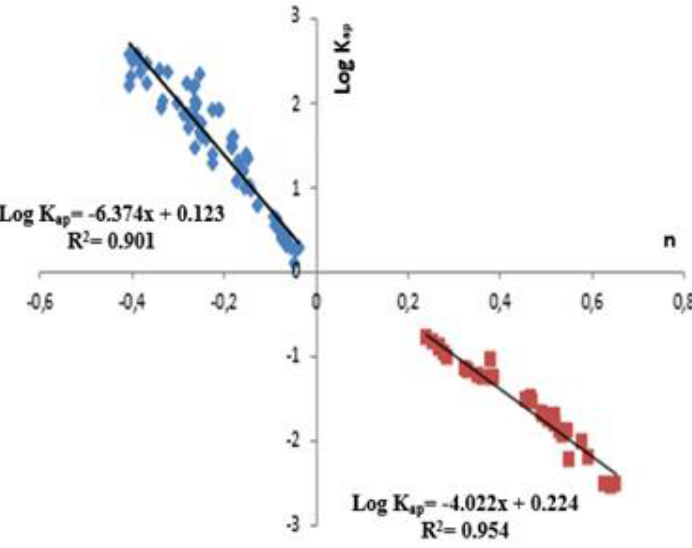
Figure 3. Variations of log Kap = f(n).